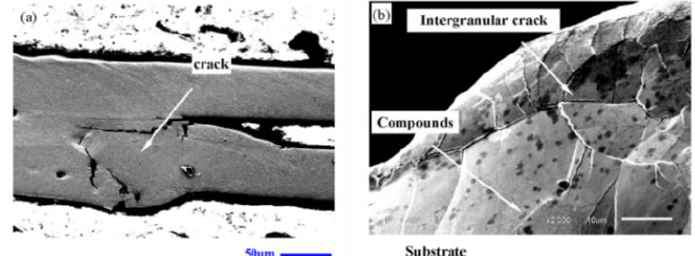
Figure 6. SEM observation of 50Mo-50Re overlap joint achieved by laser welding: ( a ) cross section and ( b ) fracture surface [29].